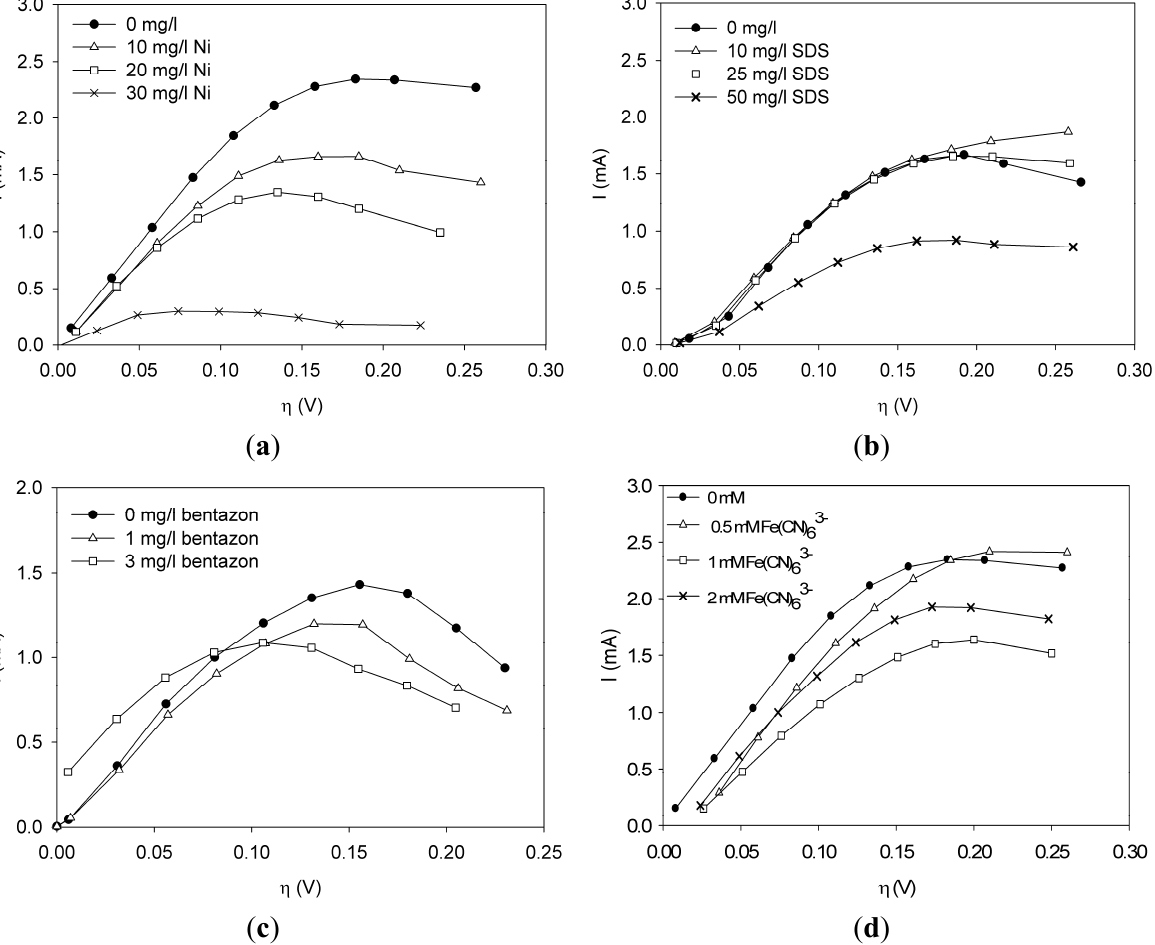
Figure 1. Effect of chemical components on the current ( a ) nickel. ( b ) sodium